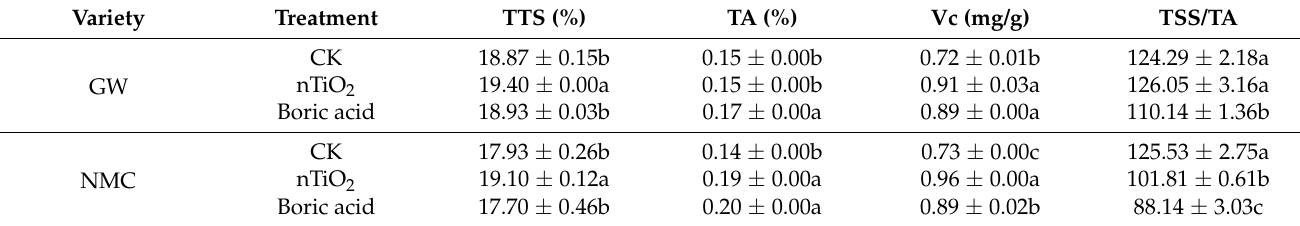
Table 1. Fruit quality influenced by nTiO 2 and boric acid in